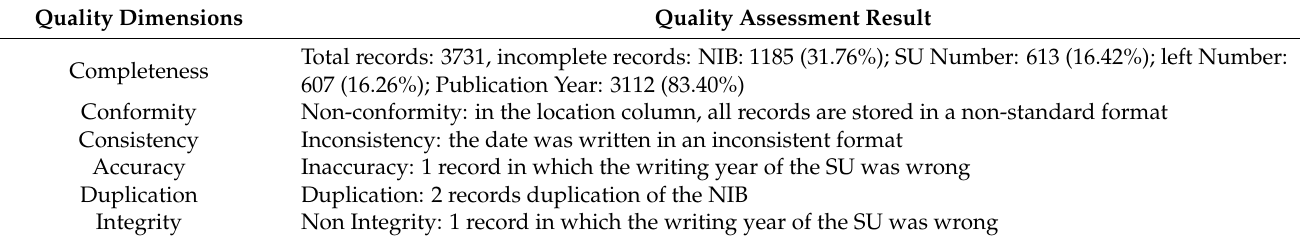
Table 2. The quality assessment